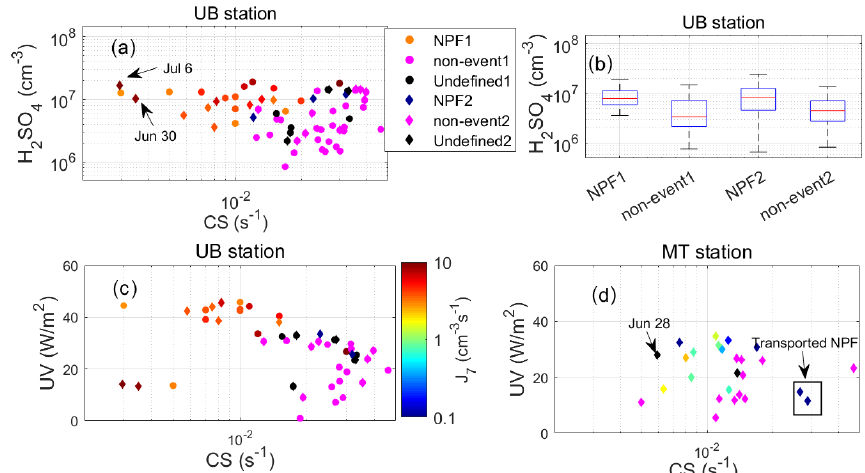
Figure 9. (a) Median condensation sink (CS, s − 1 ) and H 2 SO 4 concentration (cm − 3 ) and (b) medians and percentiles of H 2 SO 4 concentration observed at the UB station during the first 2h of NPF events and 09:00–11:00 on non-event days. (c) Solar radiation (UVA + UVB, Wm − 2 ) during the first 2h of every NPF event and 09:00–11:00 on every non-event day at the UB station. “NPF1” and “non-event1” refer to NPF event and non-event days in summer 2018 and 2019, and “NPF2” and “non-event2” refer to NPF event and non-event days during the observation from 14 June to 14 July 2019. (d) Median condensation sink (CS, s − 1 ) and solar radiation (UVA + UVB, Wm − 2 ) during the first 2h of every NPF event and 09:00–11:00 on every non-event day at the MT station. Transported NPF event cases and 1 non-event day with air masses belonging to west group (28 June) were all pointed out in the figure. The size of data points on NPF event days reflects the formation rate ( J 7 , cm − 3 s − 1 ) when it can be calculated reliably. The time resolution of CS was 8min at the UB station and 4min at the MT station, respectively. The time resolution was 30min for H 2 SO 4 data at the UB station and 1h for UV data at both stations.